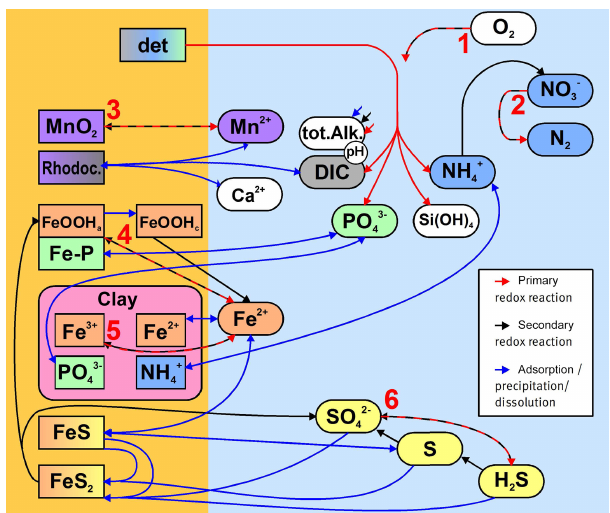
Figure 3. Simplified sketch of state variables and processes in the sediment model. Boxes to the left and right indicate sediment and pore water state variables, respectively. pH is not a state variable but calculated from DIC and total alkalinity. Red arrows show primary redox processes driven by the oxidation of organic carbon. The red numbers indicate the order in which the oxidants are utilised. Black arrows show secondary redox reactions, which means reoxidation of reduced substances. Blue arrows show adsorption–desorption or precipitation–dissolution reactions, which may depend on pH. Ab- breviations: det – detritus, Rhodoc. – rhodochrosite, tot.Alk. – total alkalinity, DIC – dissolved inorganic